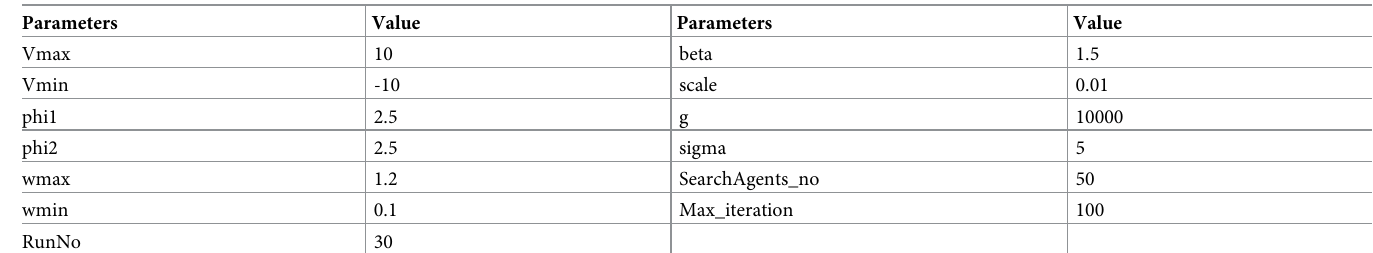
Table 1. PSOLFWM parameter setting.